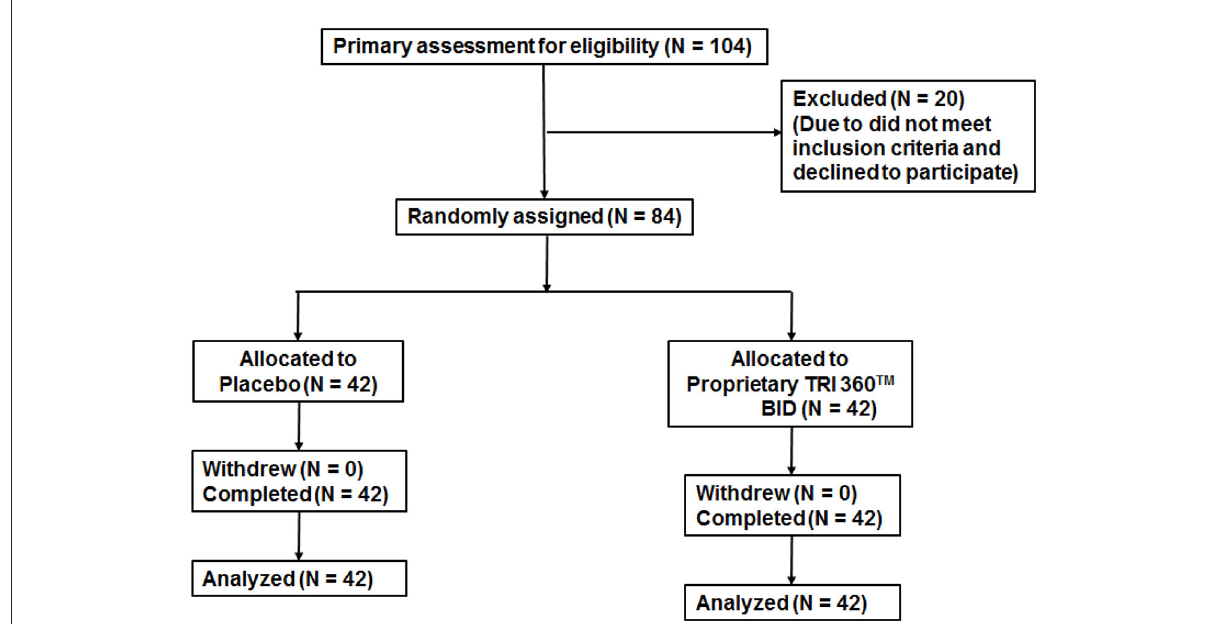
FIGURE2 Trial flow chart of subject disposition Primary recruitment identified 104 volunteers. After excluding 20 ineligible persons the authors randomly assigned 84 participants as follows: placebo ( n = 42) and proprietary TRI 360 TM ( n = 42) one capsule in the morning and one capsule in the